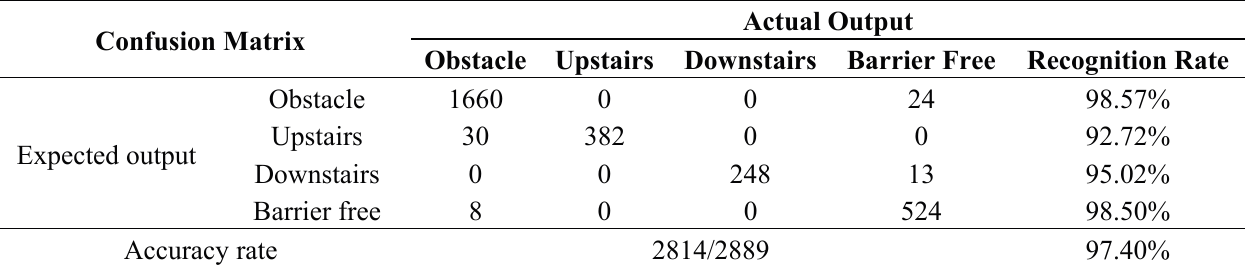
Table 6. The confusion matrix for the indoor experiment